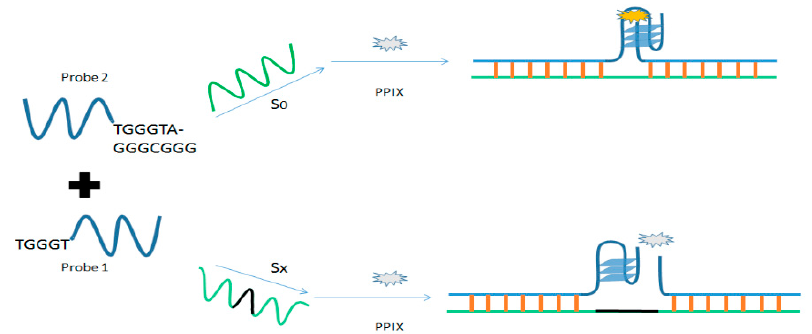
Figure 13. Activation of fluorescence of PPIX triggered by distance between two split G-quadruplex strands (x: number of bases added).